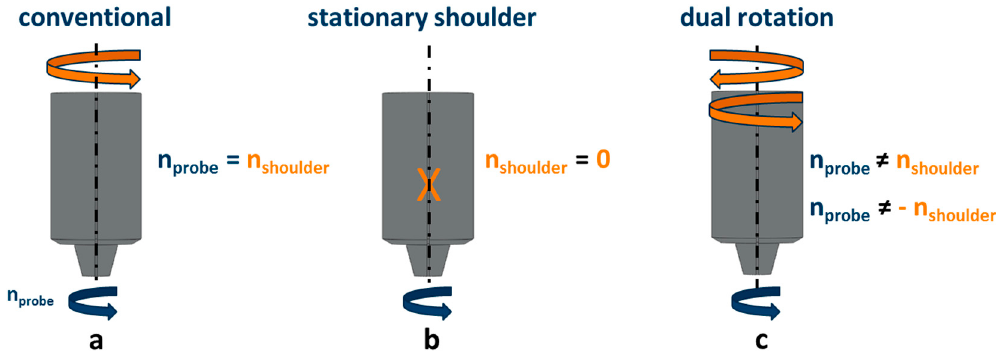
Figure 2. FSW with ( a ) conventional ( b ) stationary and ( c ) dual rotation tool configuration.